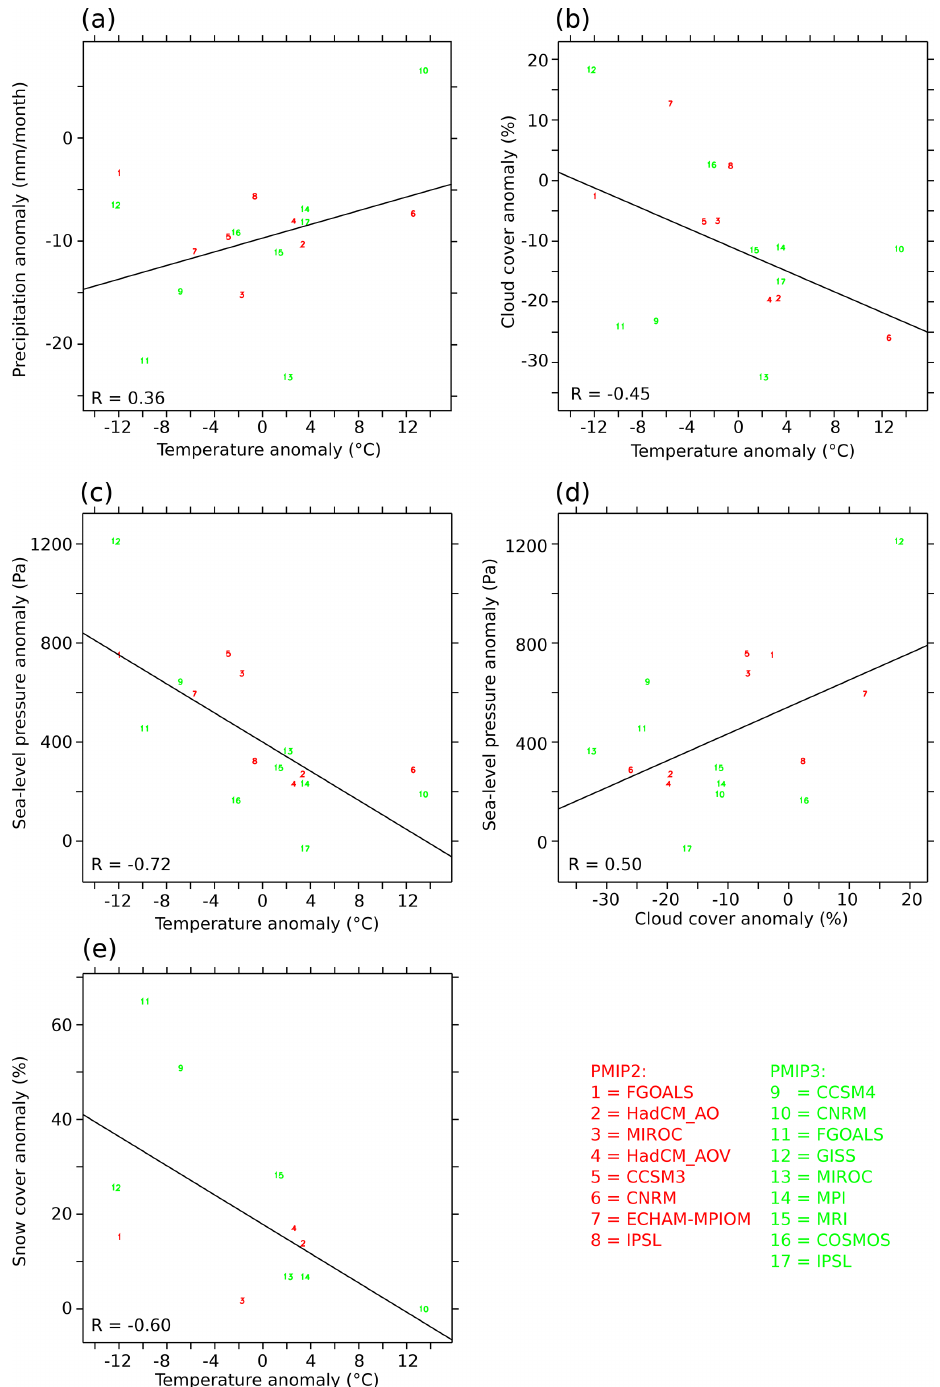
Figure 2. PMIP2 and PMIP3 LGM JJA climate anomalies averaged over the northeast Siberian target region. Red (green) numbers refer to the individual PMIP2 (PMIP3) experiments listed in the lower right. (a) Precipitation anomalies (mmmonth − 1 ) versus temperature anomalies ( ◦ C). (b) Cloud cover anomalies (%) versus temperature anomalies ( ◦ C). (c) Sea-level pressure anomalies (Pa) versus temperature anomalies ( ◦ C). (d) Sea-level pressure anomalies (Pa) versus cloud cover anomalies (%). (e) Snow cover anomalies (%) versus temperature anomalies (K). Black lines show linear fit and the R value (Pearson correlation coefficient) as listed in the lower left corners of the different subfigures. R values above 0.49 or below − 0 . 49 indicate a significant correlation ( p < 0 . 05; t